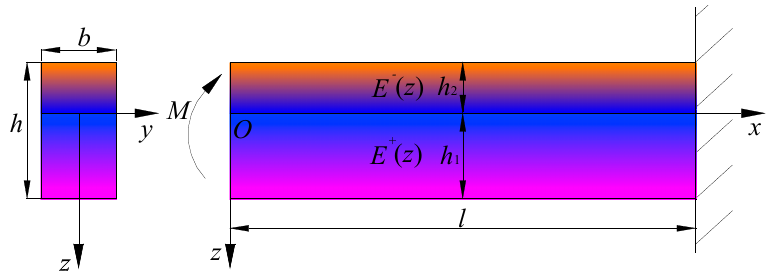
Figure 2. Scheme of a bimodular FGPM cantilever beam under pure bending.